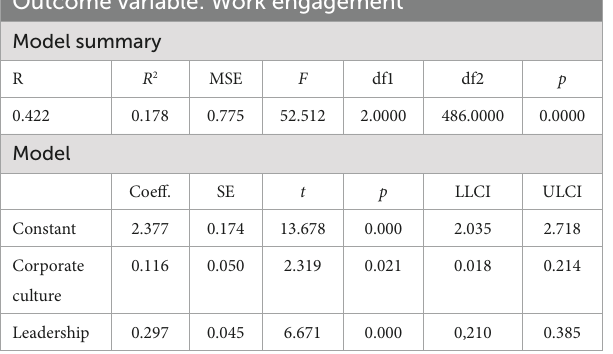
TABLE 5 Influence of corporate culture and leadership on work engagement. Outcome variable: Work engagement Model summary